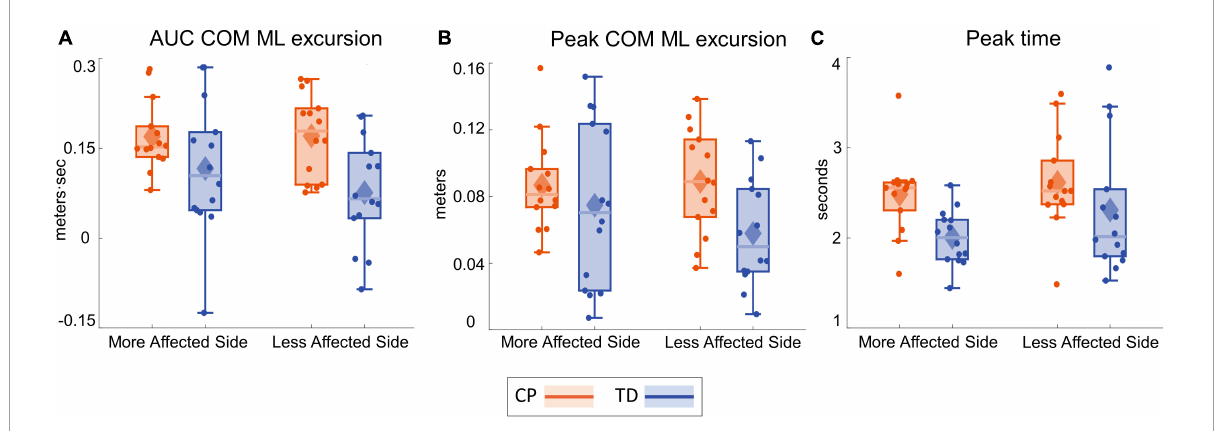
FIGURE3 Box and whisker plots, with scattered dots indicating each subject, for AUC (cid:49) COM M-L excursion (A) , Peak (cid:49) COM M-L excursion (B) and Peak time of (cid:49) COM M-L excursion (C) for CP (orange) and TD (blue) groups on the more affected (left) and less affected (right) side.